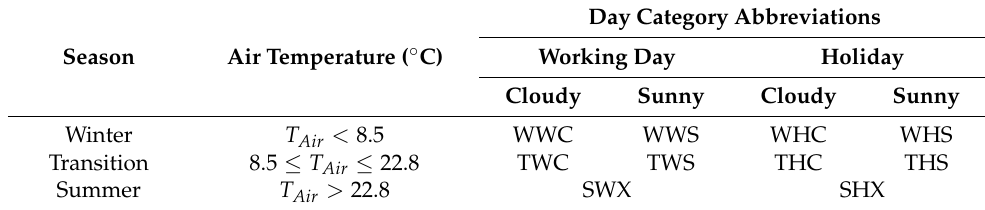
Table 2. Different day-type categories according to VDI-4655 guidelines.